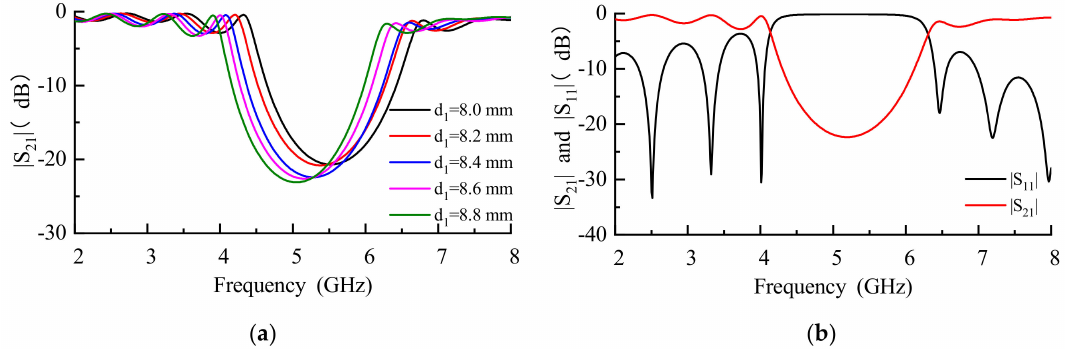
Figure 3. ( a ) S 21 with di ff erent d 1 by HFSS; ( b ) S 21 and S 11 of band stop filter based on a gradient